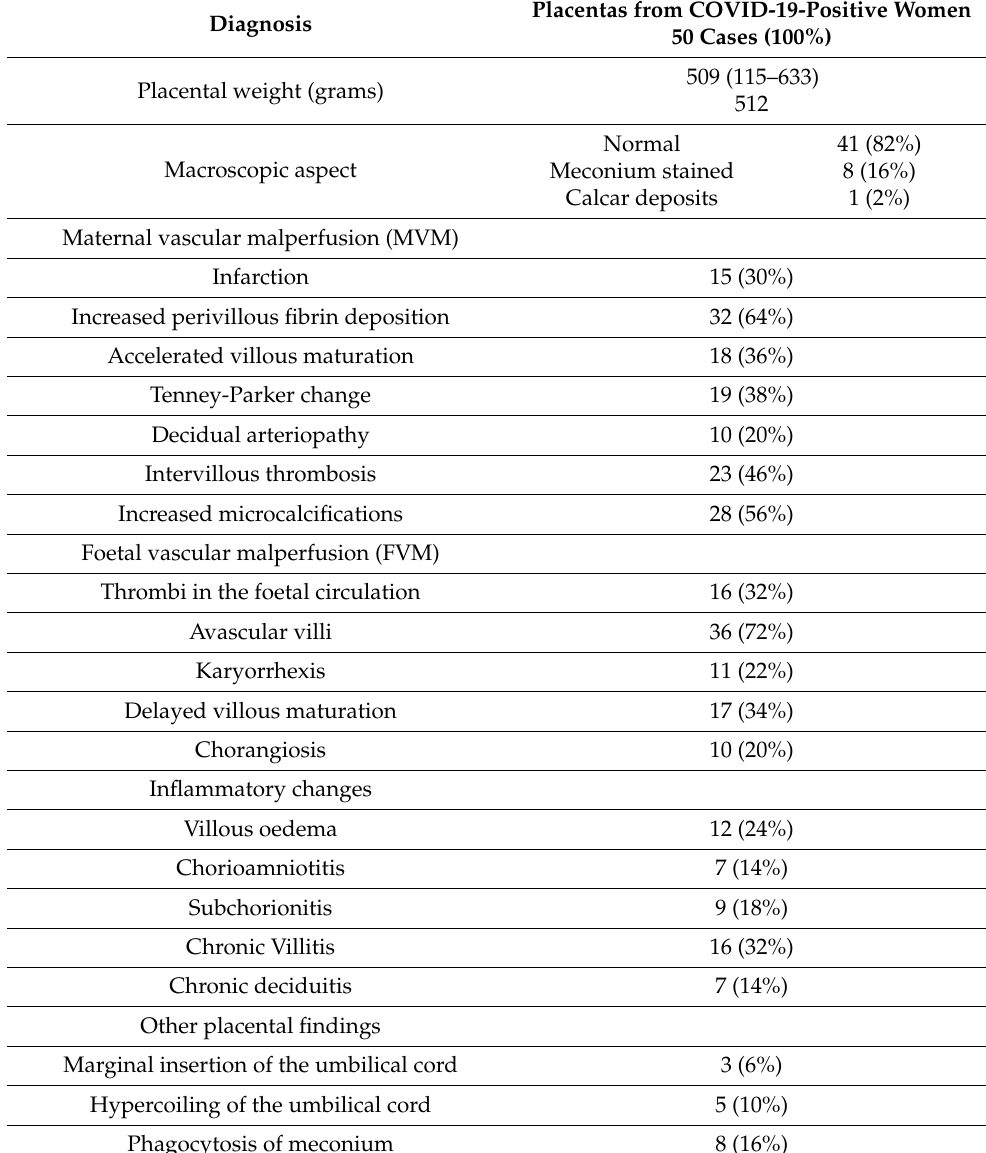
Table 3. Placental